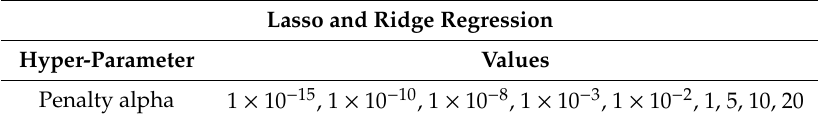
Table 10. Hyper-parameters of Lasso and Ridge